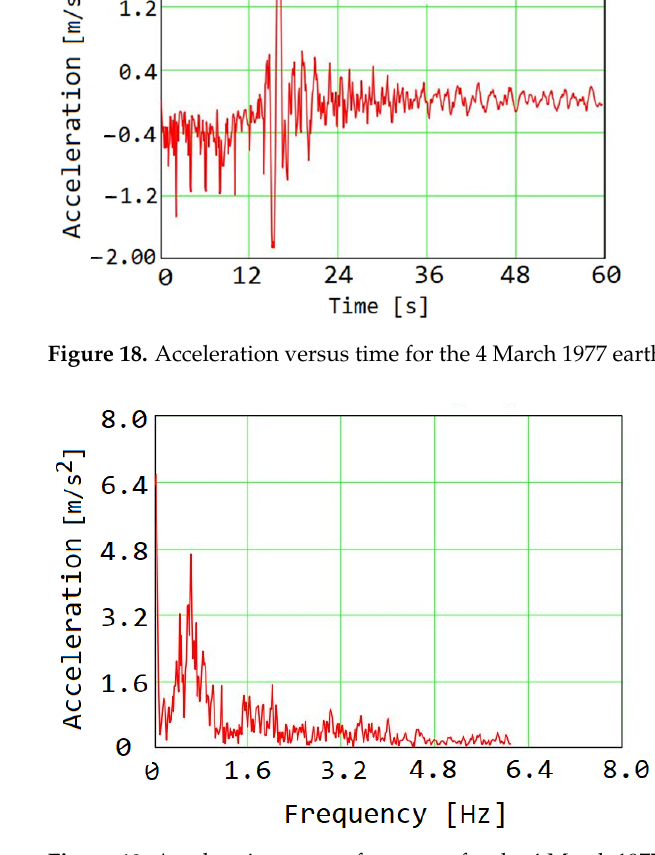
Figure 18. Acceleration versus time for the 4 March 1977 earthquake.